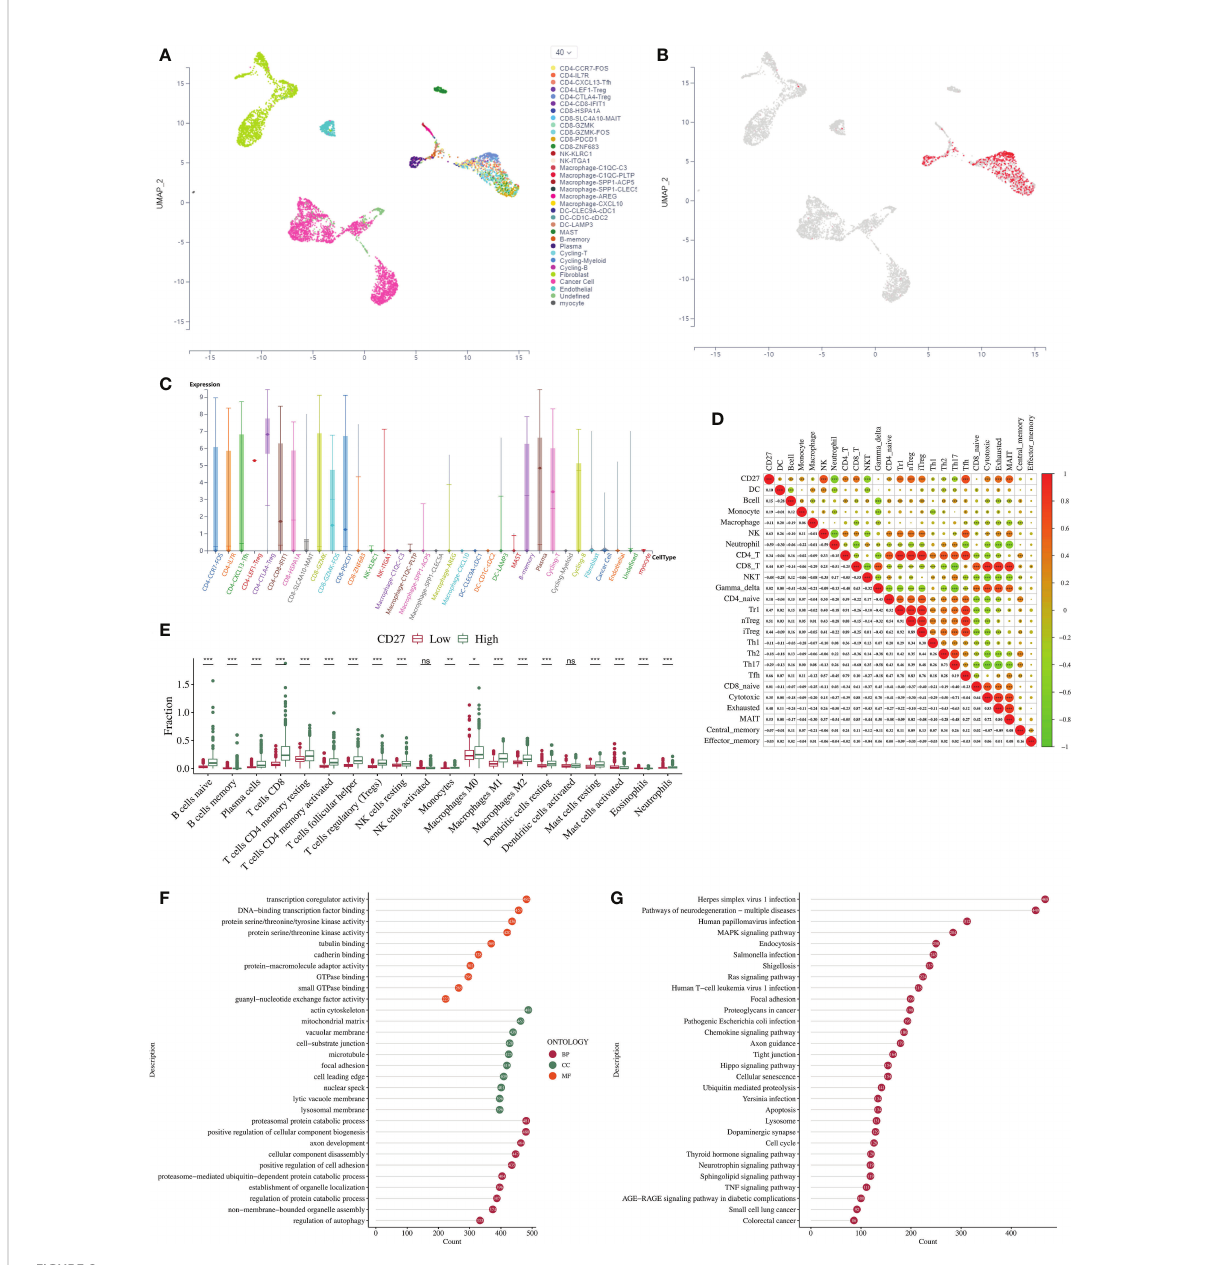
FIGURE 2 Analysis of the immune-cell in fi ltration and the DEGs associated with CD27 expression in HNSCC. (A) Clustering of 40 types of immune cells. (B) Immune cells exhibiting CD27 expression. (C) Expression and distribution of CD27 in 33 types of immune cells. (D) Correlations between CD27 expression and immune-cell in fi ltration in HNSCC in the ImmuCellAI database. (E) Correlations between CD27 expression and immune-cell in fi ltration in HNSCC in the CIBERSORTx database. (F) GO enrichment analysis. (G) KEGG enrichment analysis. * p < 0.05, ** p < 0.01, *** p < 0.001, NS, no signi fi